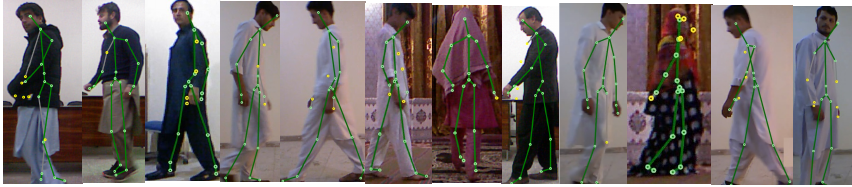
Figure 2. Walking of subjects in different